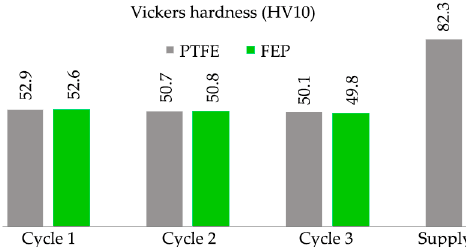
Figure 9. Vickers hardness values (HV10 method) of substrates EN AW 5251 after the thermal cycles of polymerization, coating, and stripping by laser, for FEP and PTFE coatings.